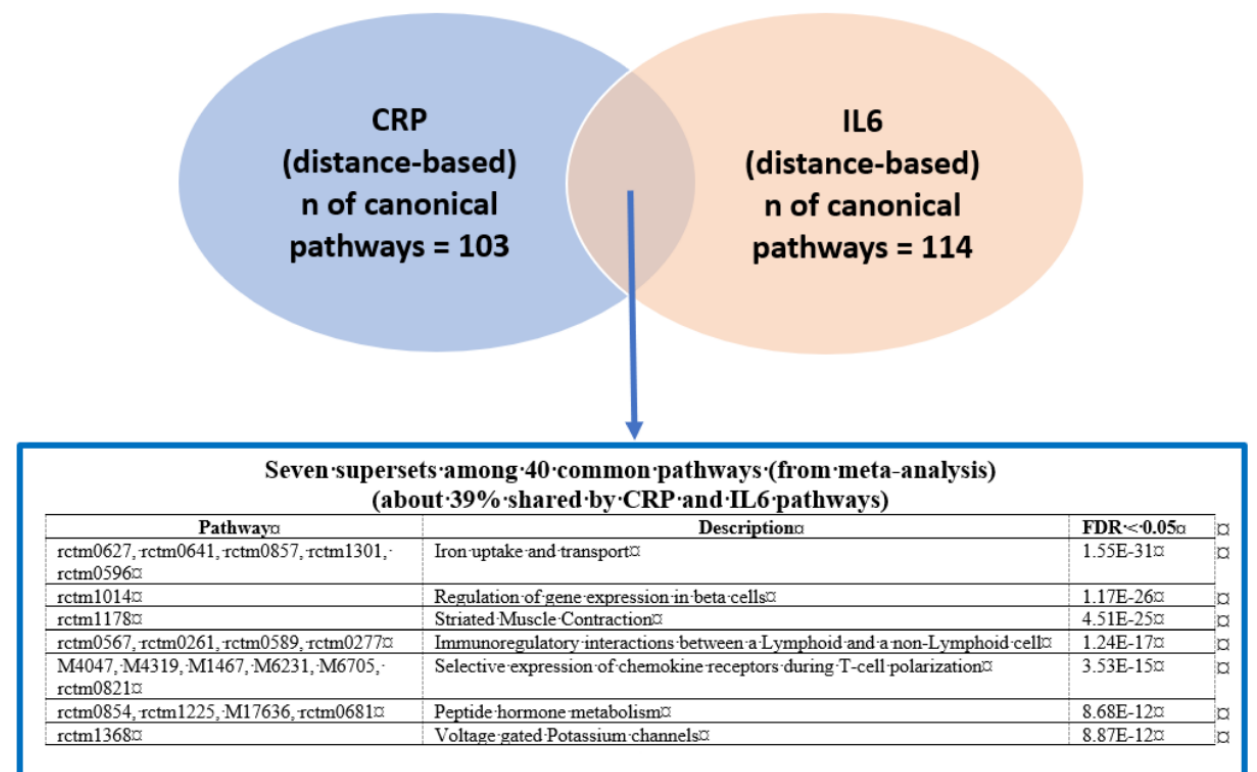
Figure 1. Comparison of significant pathways (false discovery rate [FDR] < 0.05) between C-reactive protein (CRP) and interleukin-6 (IL6) phenotypes (CRP/IL6, 50-kb distance–based mapping).